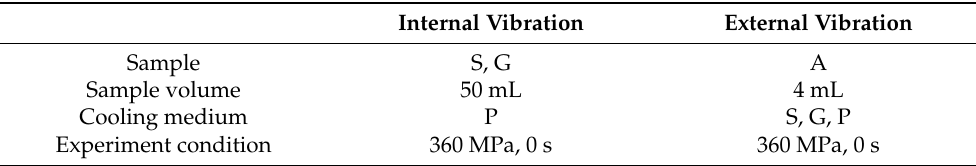
Table 1. Experimental design of phase transition position studies. Internal Vibration External Vibration Sample S, G A Sample volume 50